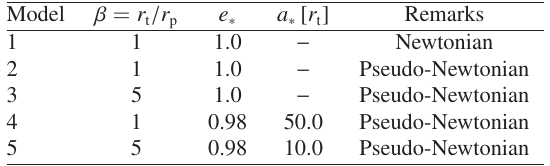
Table 1. The first column shows each simulated scenario. The second, third, and fourth columns are the penetration factor β = r p / r T , the initial orbital eccentricity of star-black hole system e ∗ , and its initial semi-major axis a ∗ , respectively. The last column describes the remark for each model.